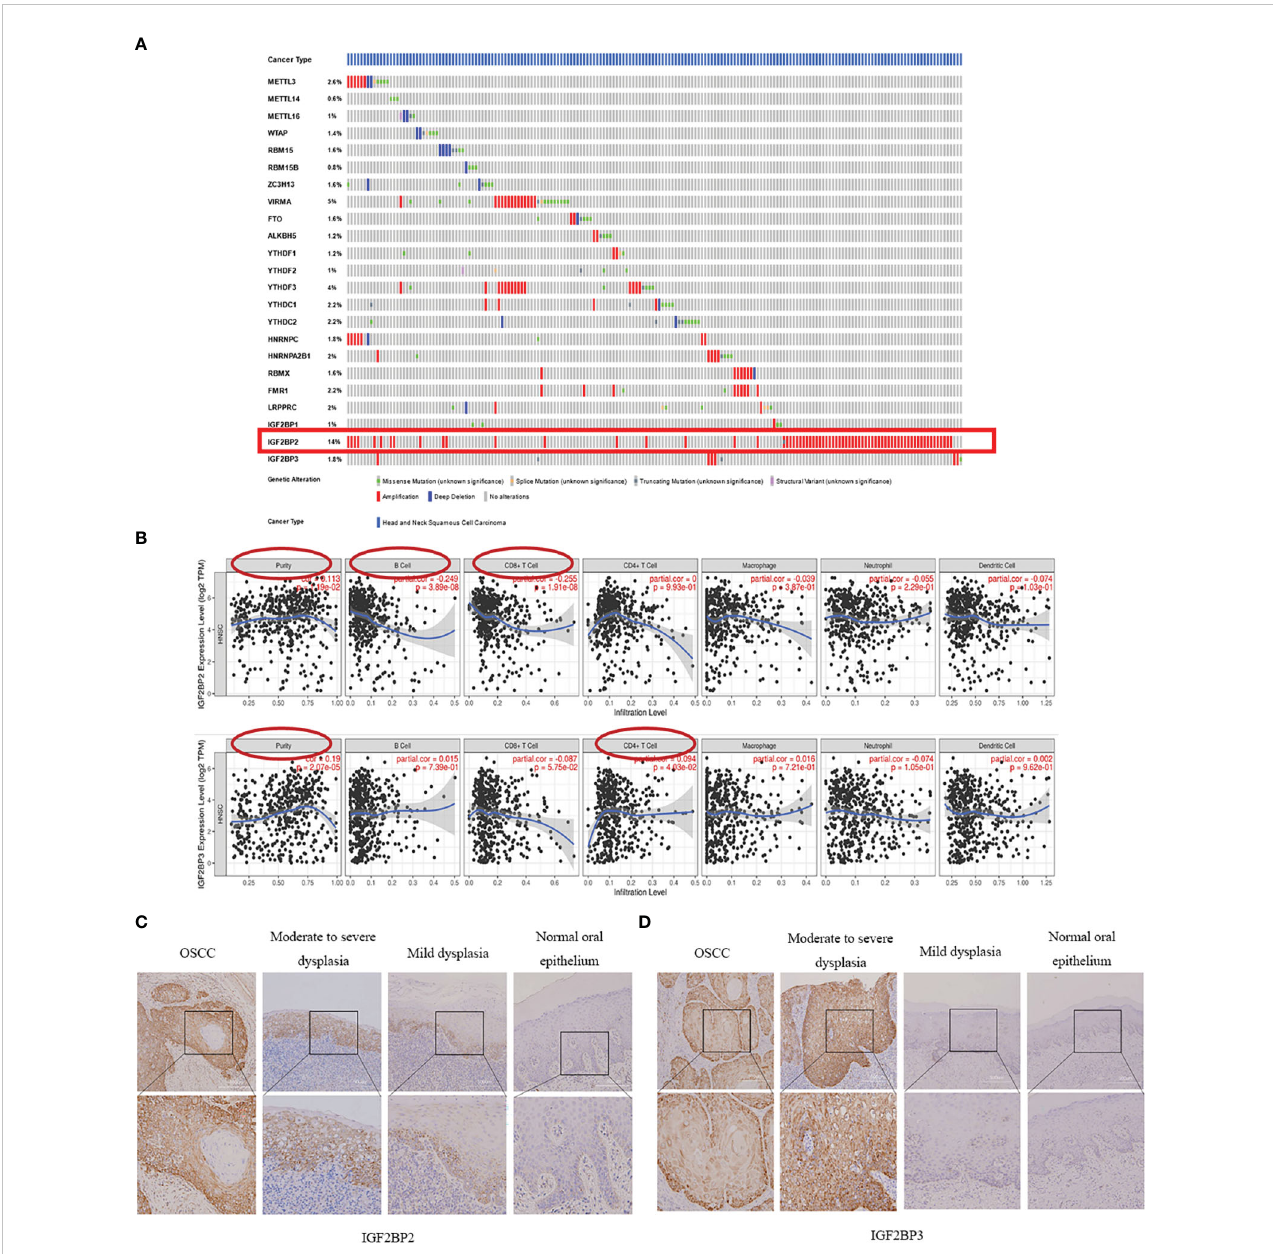
FIGURE 2 Mutation frequency of m6A methylation regulators in HNSCC and their association with IGF2BP2 and IGF2BP3. (A) The mutation frequency of m6A methylation regulators in HNSCC (The cBioPortal database). (B) The correlation of IGF2BP2 and IGF2BP3 expressions with immune cell in fi ltration in patients with HNSCC. (C, D) Protein expression of IGF2BP2 and IGF2BP3 in oral simple epithelial hyperplasia, OED and OSCC increased